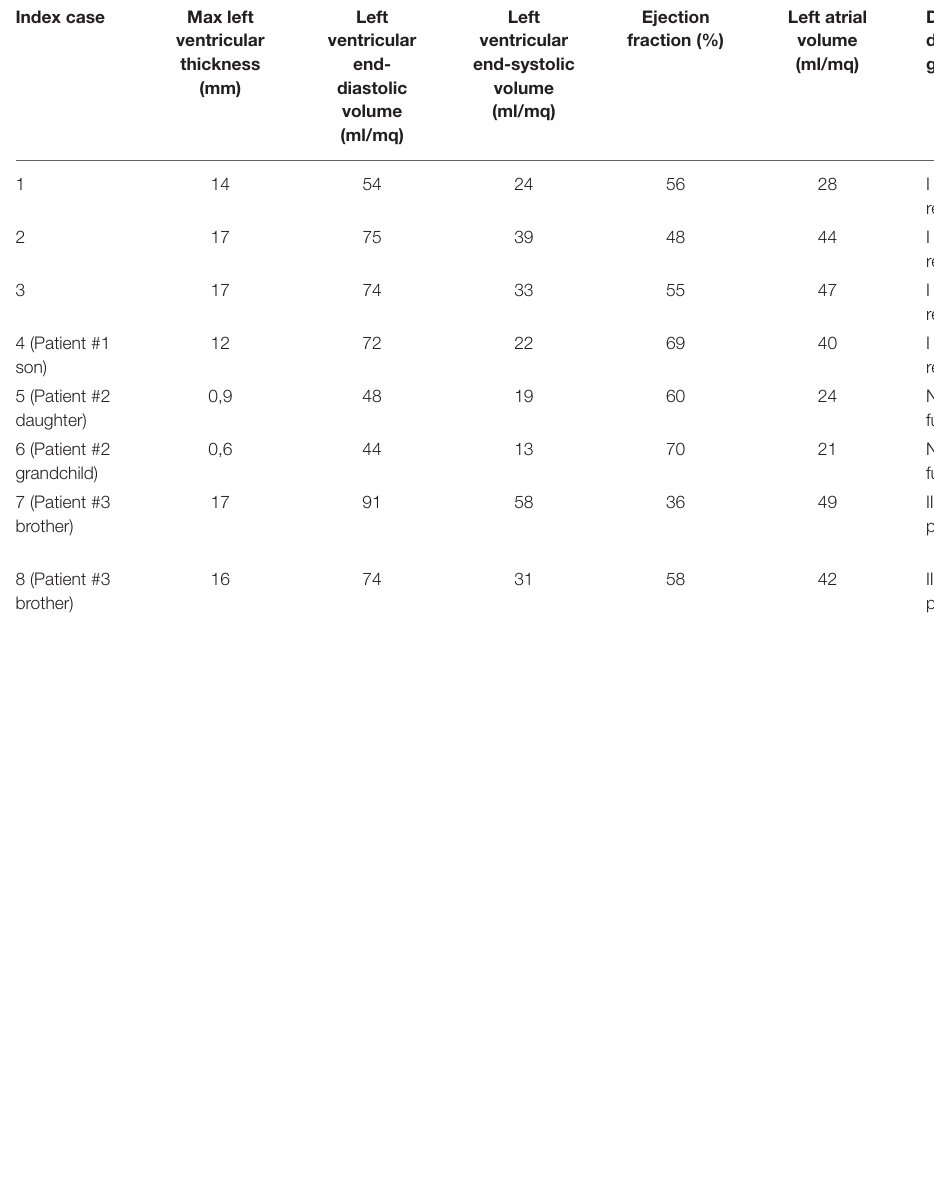
TABLE 2 | Main echocardiographic findings of FD